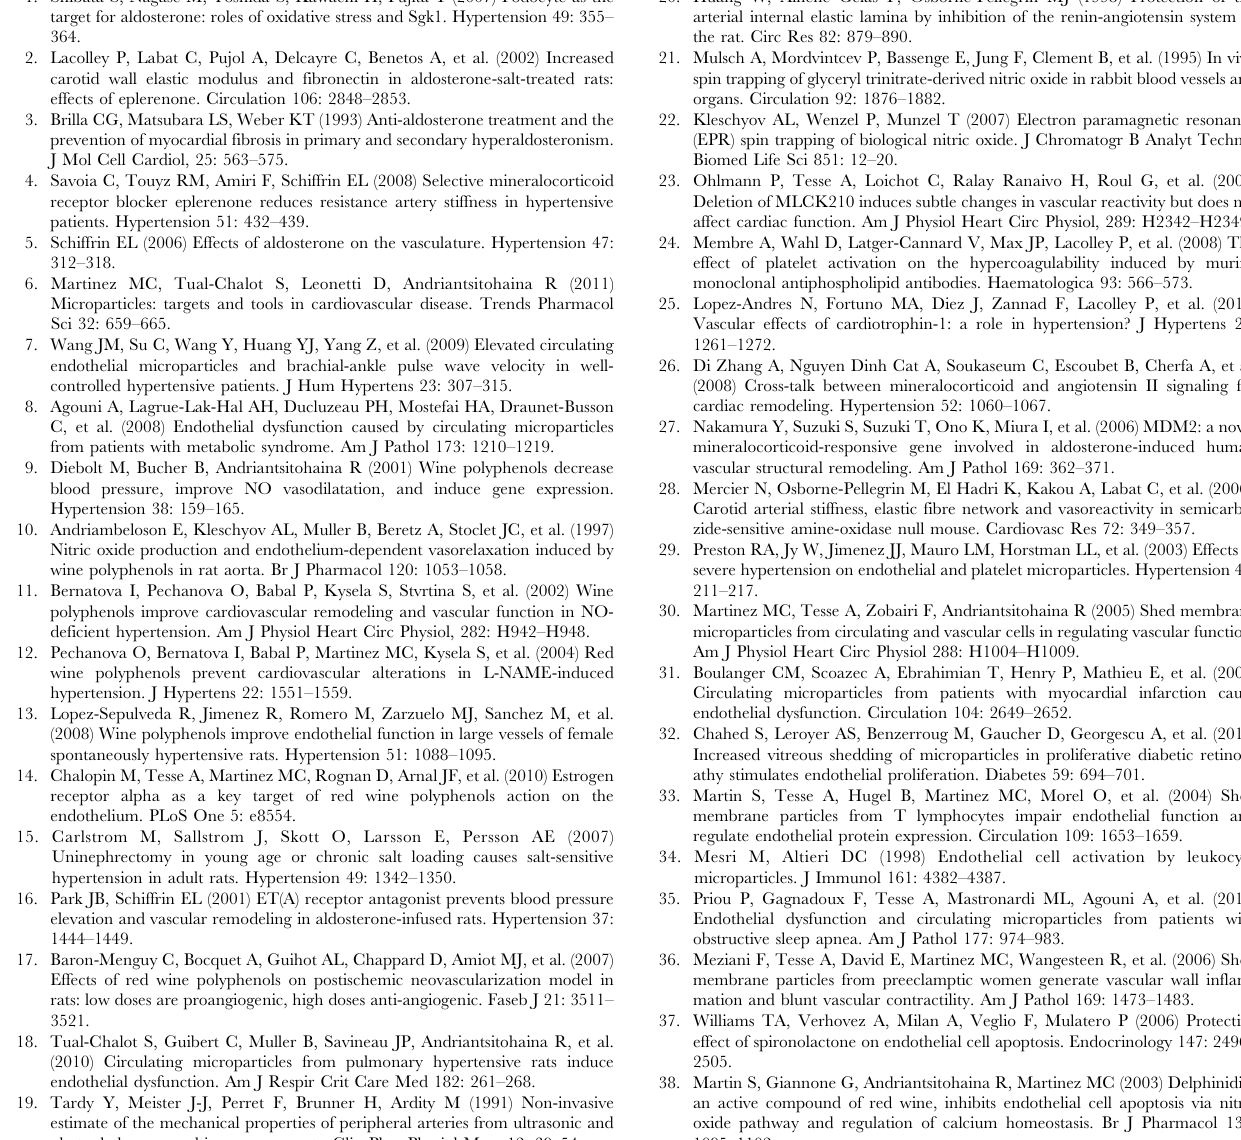
sample Wds) in aorta from Control, Spironolactone (Spiro) and Provinols TM (Prov) rats (n= 6 for each group). Table S1 Effects of treatment by spironolactone (Spiro) or Provinols TM (Prov) on blood pressure, carotid diameter and organ weights in